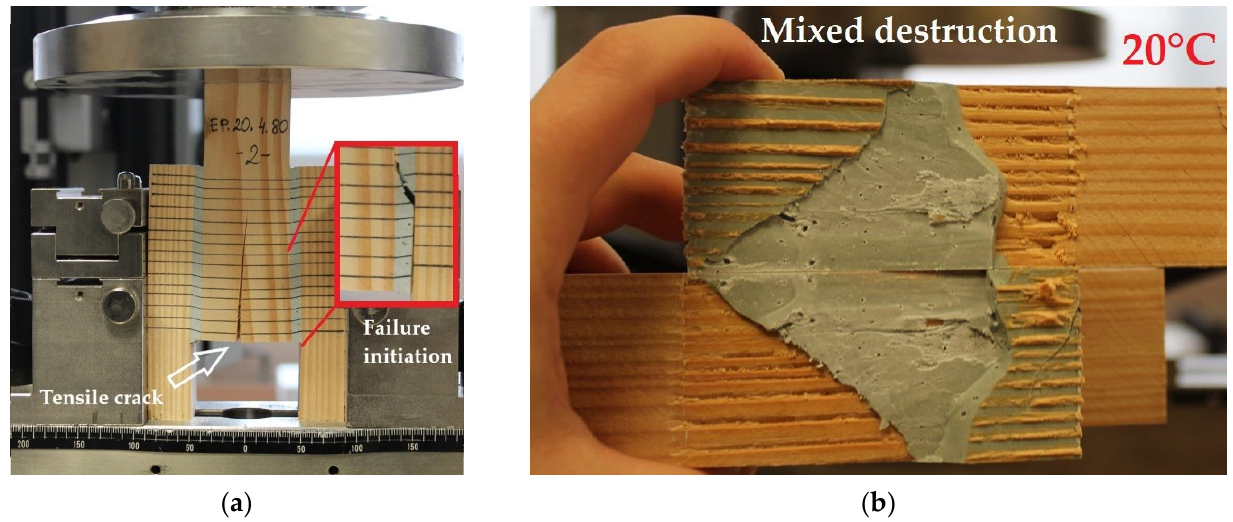
Figure 10. Failure of the reference t = 4 mm specimen: ( a ) premature failure as a result of tension perpendicular to the grain and failure initiation; ( b ) join cross section—mixed failure (adhesive failure on the wood-polymer interface and cohesive failure in the polymer).